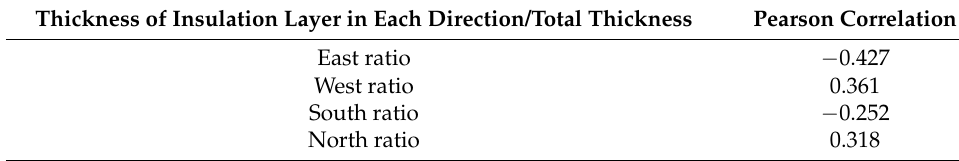
Table 8. Comparison of the model before and after the generation of building shape. Thickness of Insulation Layer in Each Direction/Total